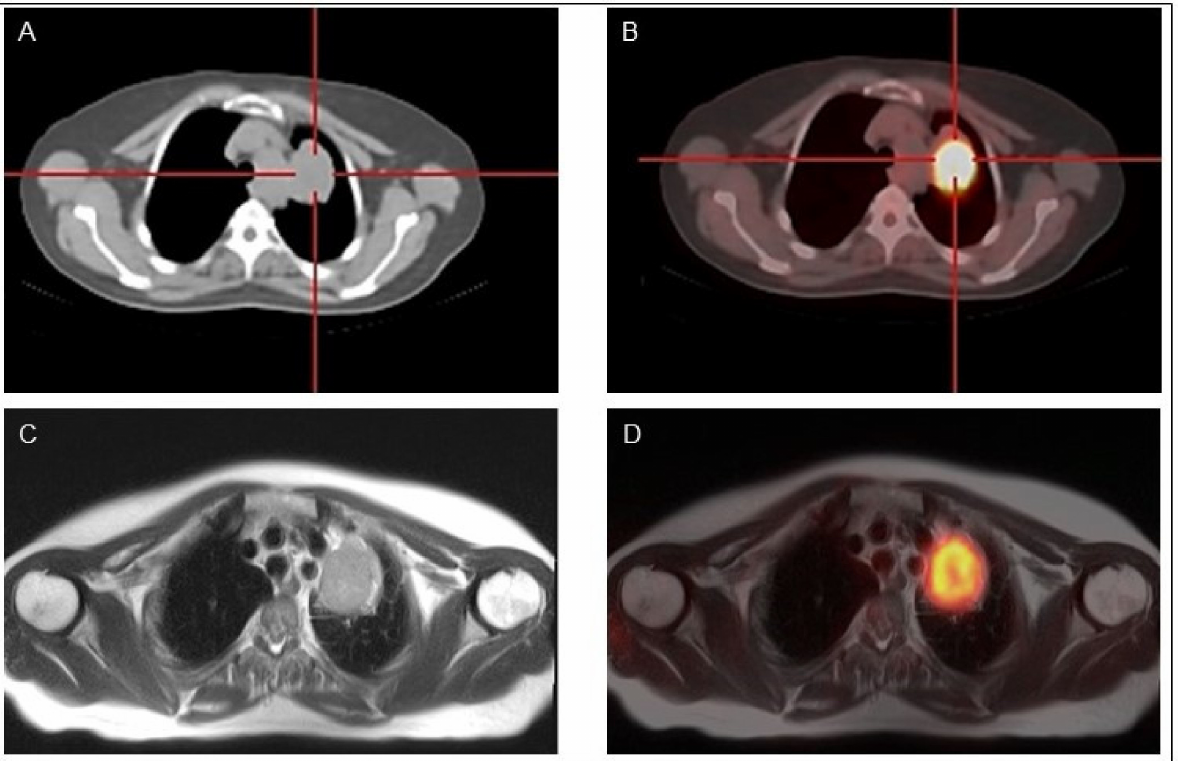
Figure 4. Classical papillary thyroid cancer in a 45-year-old man 18 F-FDG PET-CT ( A,B ) and 18 F-FDG PET-MR ( C,D ) show a mediastinal lymph node with high 18 F-FDG